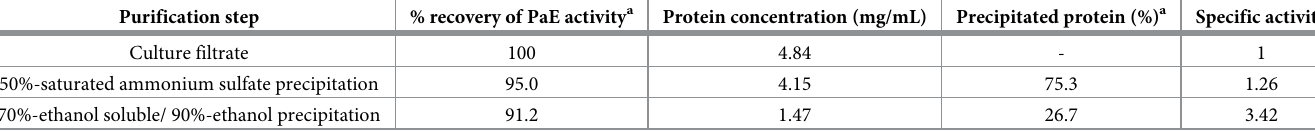
Table 3. Concentration of PaE by combination of ammonium sulfate precipitation and ethanol precipitation. Purification